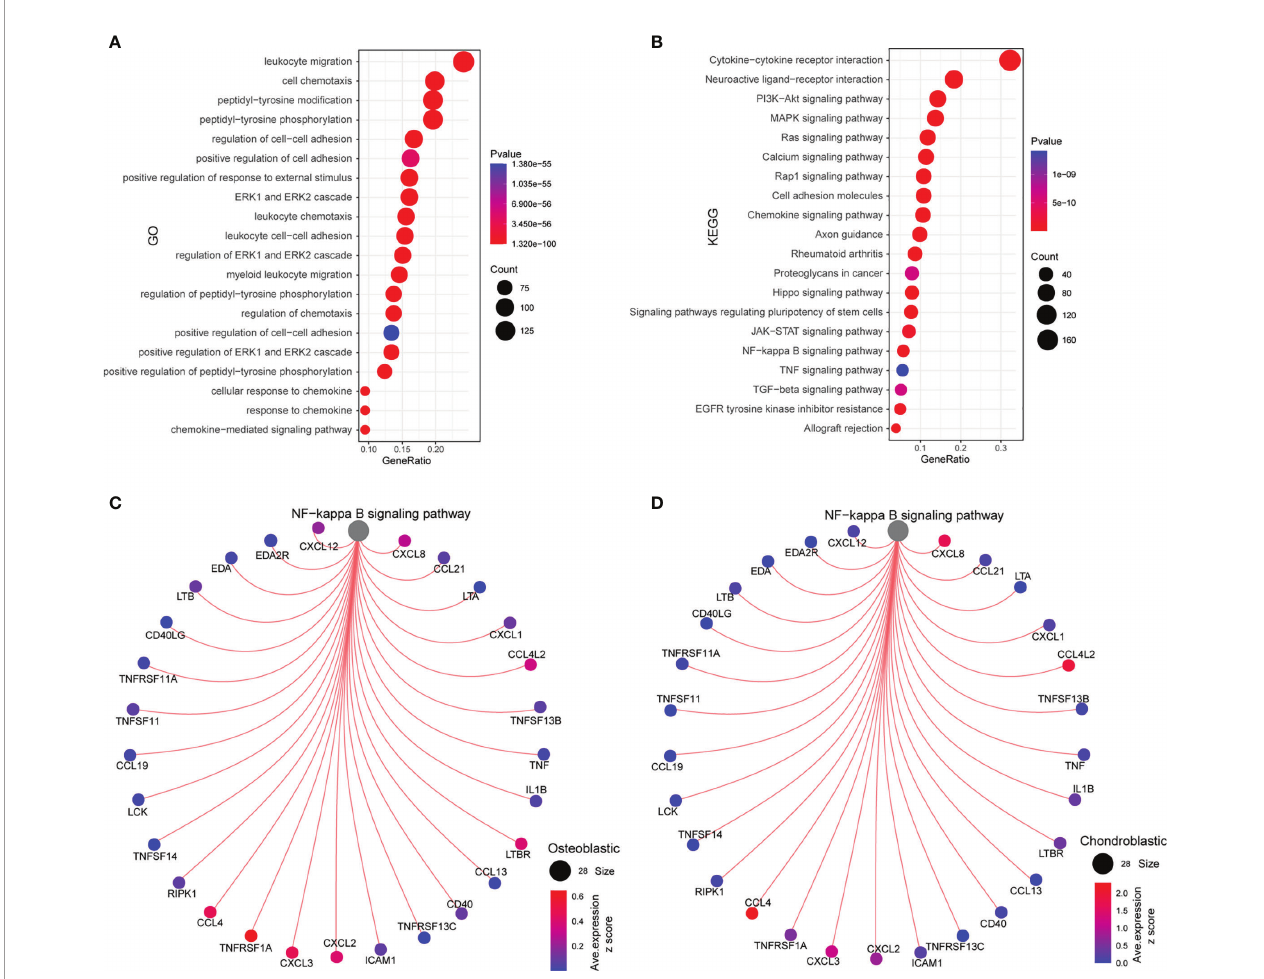
FIGURE 5 | Functional enrichment analysis and interaction between the NF- k B signaling pathway and ligands/receptors. (A) GO enrichment analysis of common ligands/receptors among primary, metastatic, and recurrent osteosarcomas; (B) KEGG enrichment analysis of common ligands/receptors among primary, metastatic, and recurrent osteosarcomas. (C) The interaction between the NF- k B signaling pathway and common ligands/receptors in osteoblastic cells. (D) The interaction between the NF- k B signaling pathway and common ligands/receptors in chondroblastic